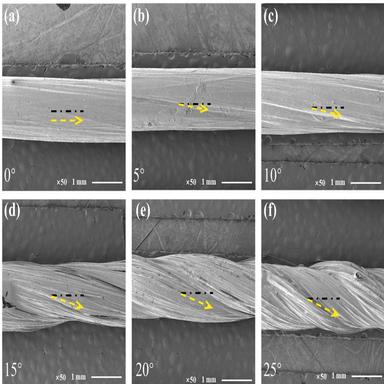
Scanning electron micrographs of carbon fiber tows with different twist angles.